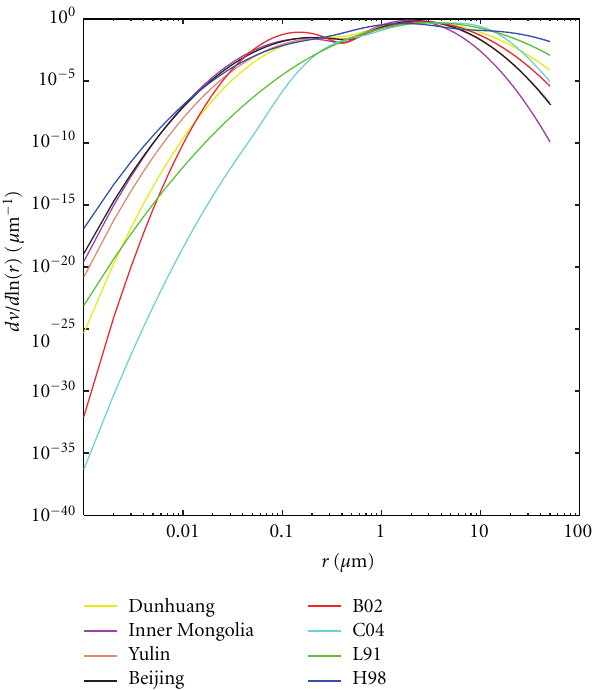
Figure 1: Normalized dust volume size distributions for the dust cases considered in this study (see text for details). The associated size distribution parameters are given in Table 1.